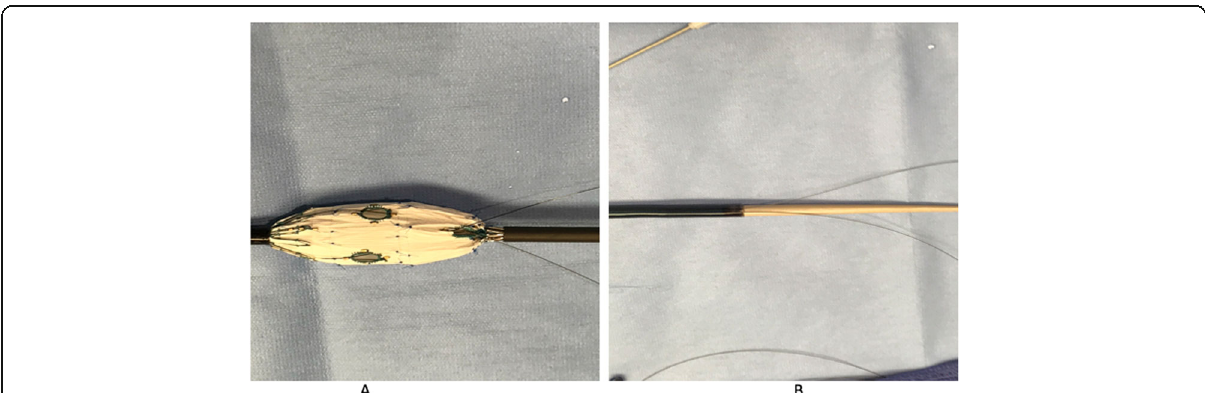
Fig. 2 a Loading wires in a fenestrated device. The Cook Zen-fen proximal graft was ordered with 1 scallop to accommodate the SMA and 2 small fenestrations to accommodate renal arteries. The device is deployed on a sterile back table and a 0.014 and 0.018 long wires are placed through the scallop into the body of the fenestration device, out through the small (renal) fenestrations. b Re-sheathed the device after loading wires. The device is now re-sheathed and ready to be implanted. The preloaded wires allow for cannulation of target vessels and placement